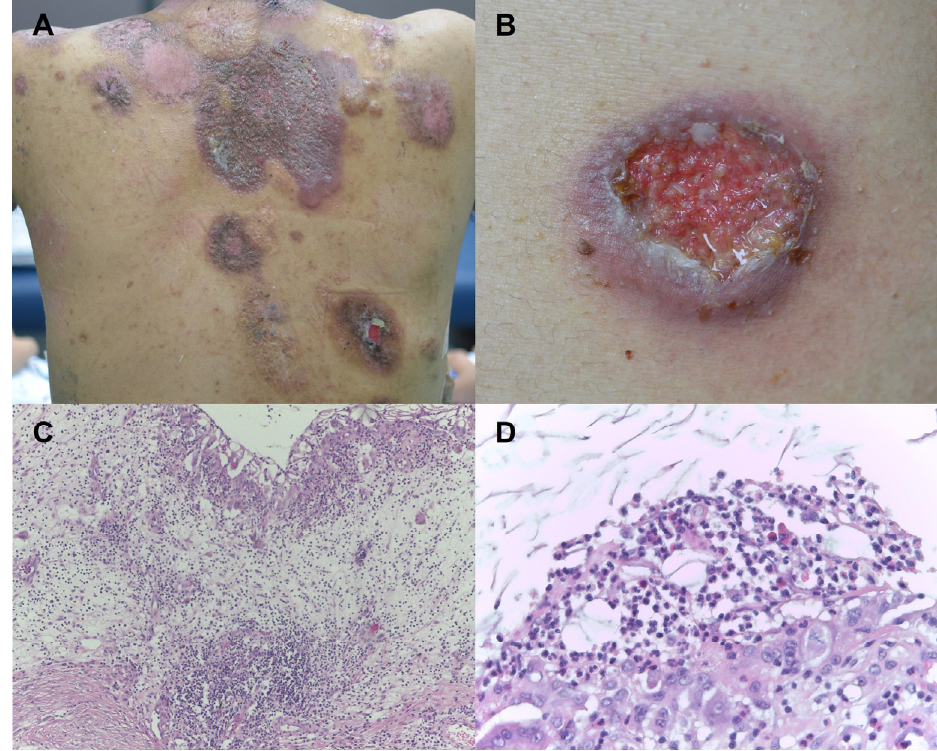
Figure 1. Skin findings of the patient. ( A ) Multiple violaceous erosive and ulcerative patches were sca tt ered over the body. ( B ) Ulcerative patch with undermined violaceous border was observed. ( C ) Histopathologic examination showed intense neutrophilic in fi ltration with epidermal necrosis and dermal edema (H&E, ×100). ( D ) Neutrophilic and histiocytic in fi ltration was noted. (H&E, ×400).